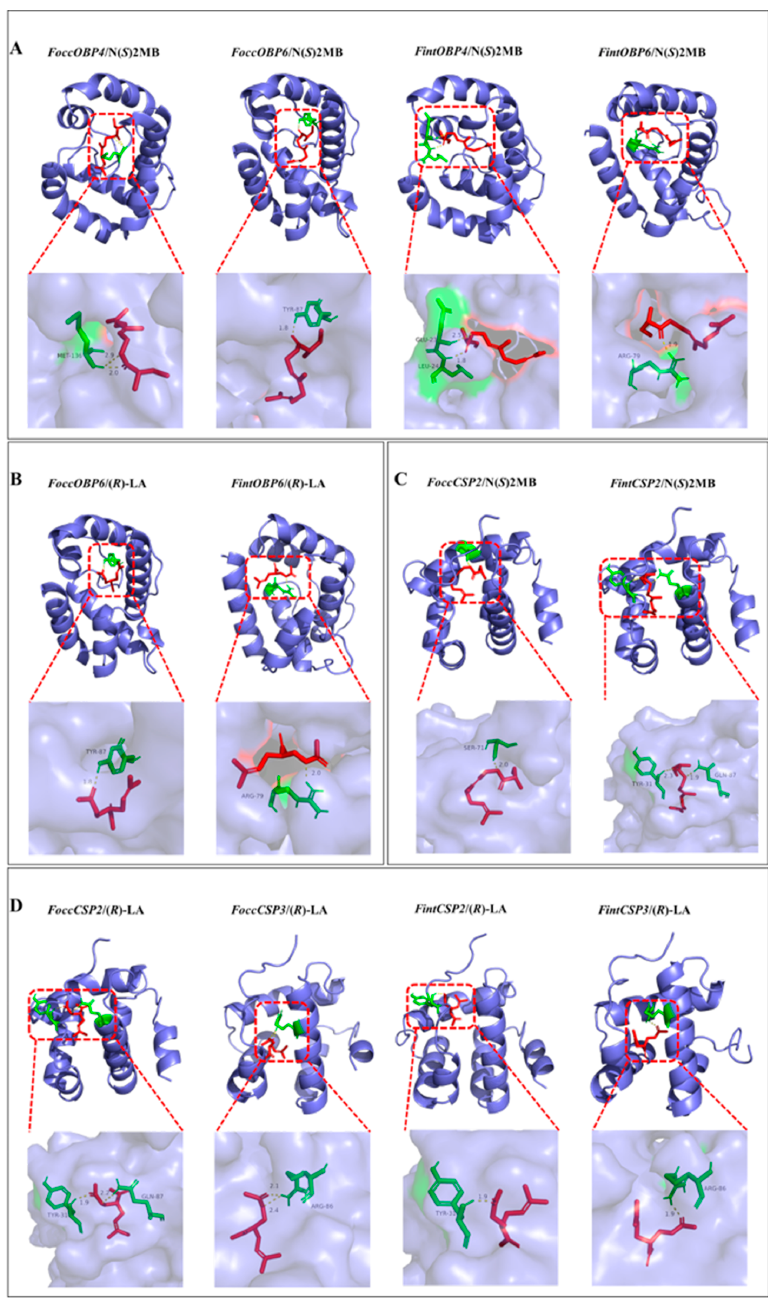
Figure 8. Three-dimensional models of OBPs/CSPs and aggregation pheromone com- pounds interactions in Frankliniella occidentalis and Frankliniella intonsa . N( S )2MB: neryl ( S )- 2-methylbutanoate; ( R )-LA: ( R )-lavandulyl acetate. ( A ). Interactions between N( S )2MB and FoccOBP4/FoccOBP6/FintOBP4/FintOBP6; ( B ). Interactions between ( R )-LA and FoccOBP6/ Fin- tOBP6; ( C ). Interactions between N( S )2MB and FoccCSP2/FintCSP2; ( D ). Interactions between ( R )-LA and